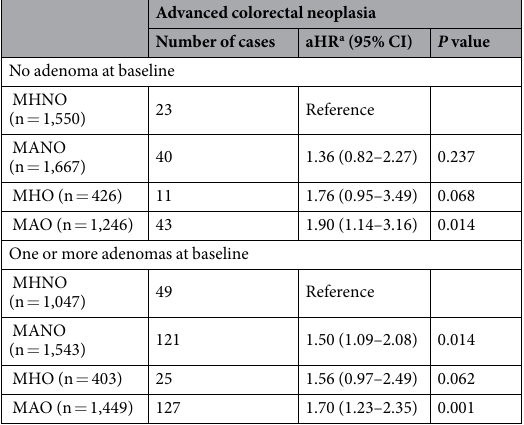
Table 4. The risk of metachronous advanced colorectal neoplasia by metabolic status and obesity using the International Diabetes Federation waist circumference cut-points a in subgroups with or without adenomas at baseline. a International Diabetes Federation waist circumference cut-points: ≥ 90 cm for men and ≥ 80 cm for women. b Estimated from Cox proportional hazard models adjusted for age, sex, smoking status, alcohol intake, regular exercise, regular aspirin use, family history of colorectal cancer, and high risk adenoma at screening colonoscopy. aHR, adjusted hazard ratio; CI, confidence interval; BMI, body mass index; MHNO, metabolically healthy non-obese; MANO, metabolically abnormal non-obese; MHO, metabolically healthy obese; MAO, metabolically abnormal